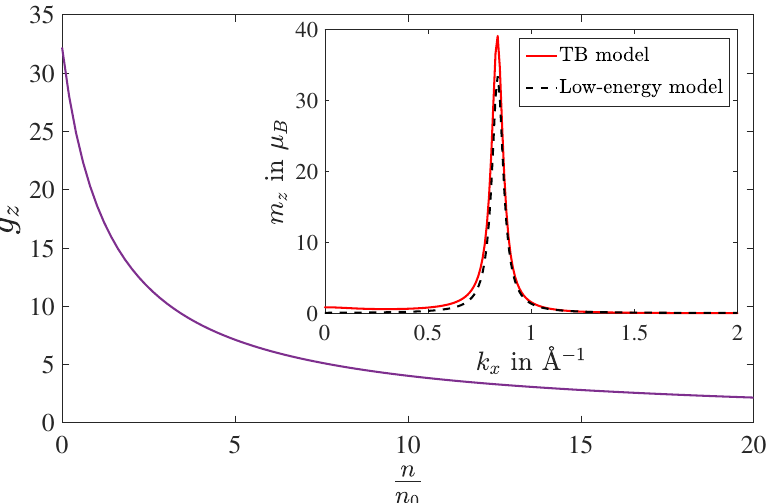
Figure 2: (Color online) Depicts the effective orbital g -factor for out-of-plane mag- netic field, g as a function of n . Inset shows the magnitude of the orbital magnetic z n 0 moment (in units of µ ) as a function of k for the lowest conduction band using B x tight-binding model (solid line) and the Hamiltonian given in Eq. (8) (dashed line). = 40 meV, v = − 6.44 × 10 5 m / s and v = 3.65 × 10 5 m / Here we have taken ∆ so x y